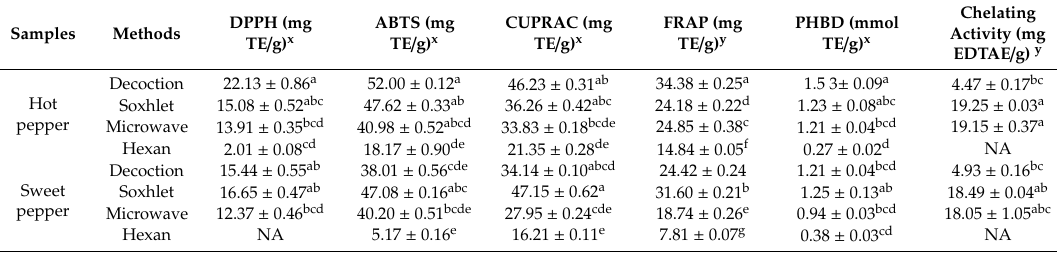
Table 3. Antioxidant properties of the tested